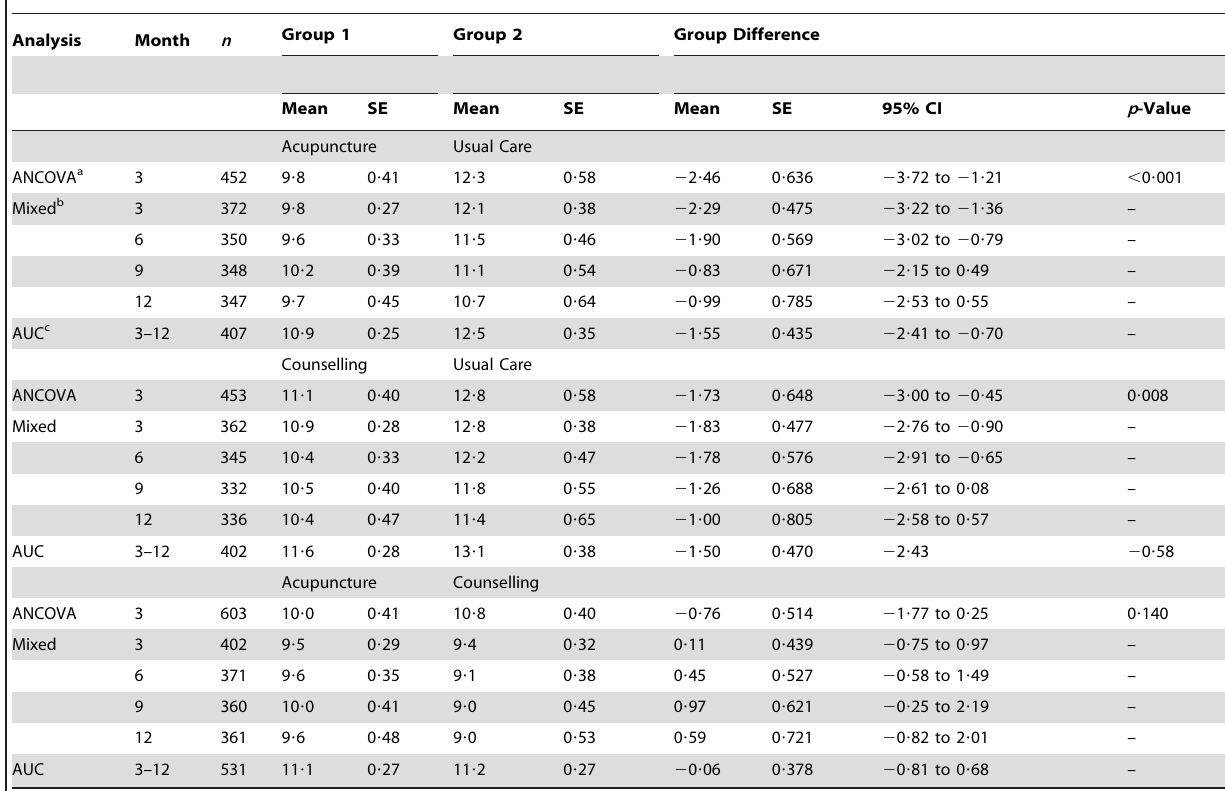
Table 3. Effect of trial arm on PHQ-9